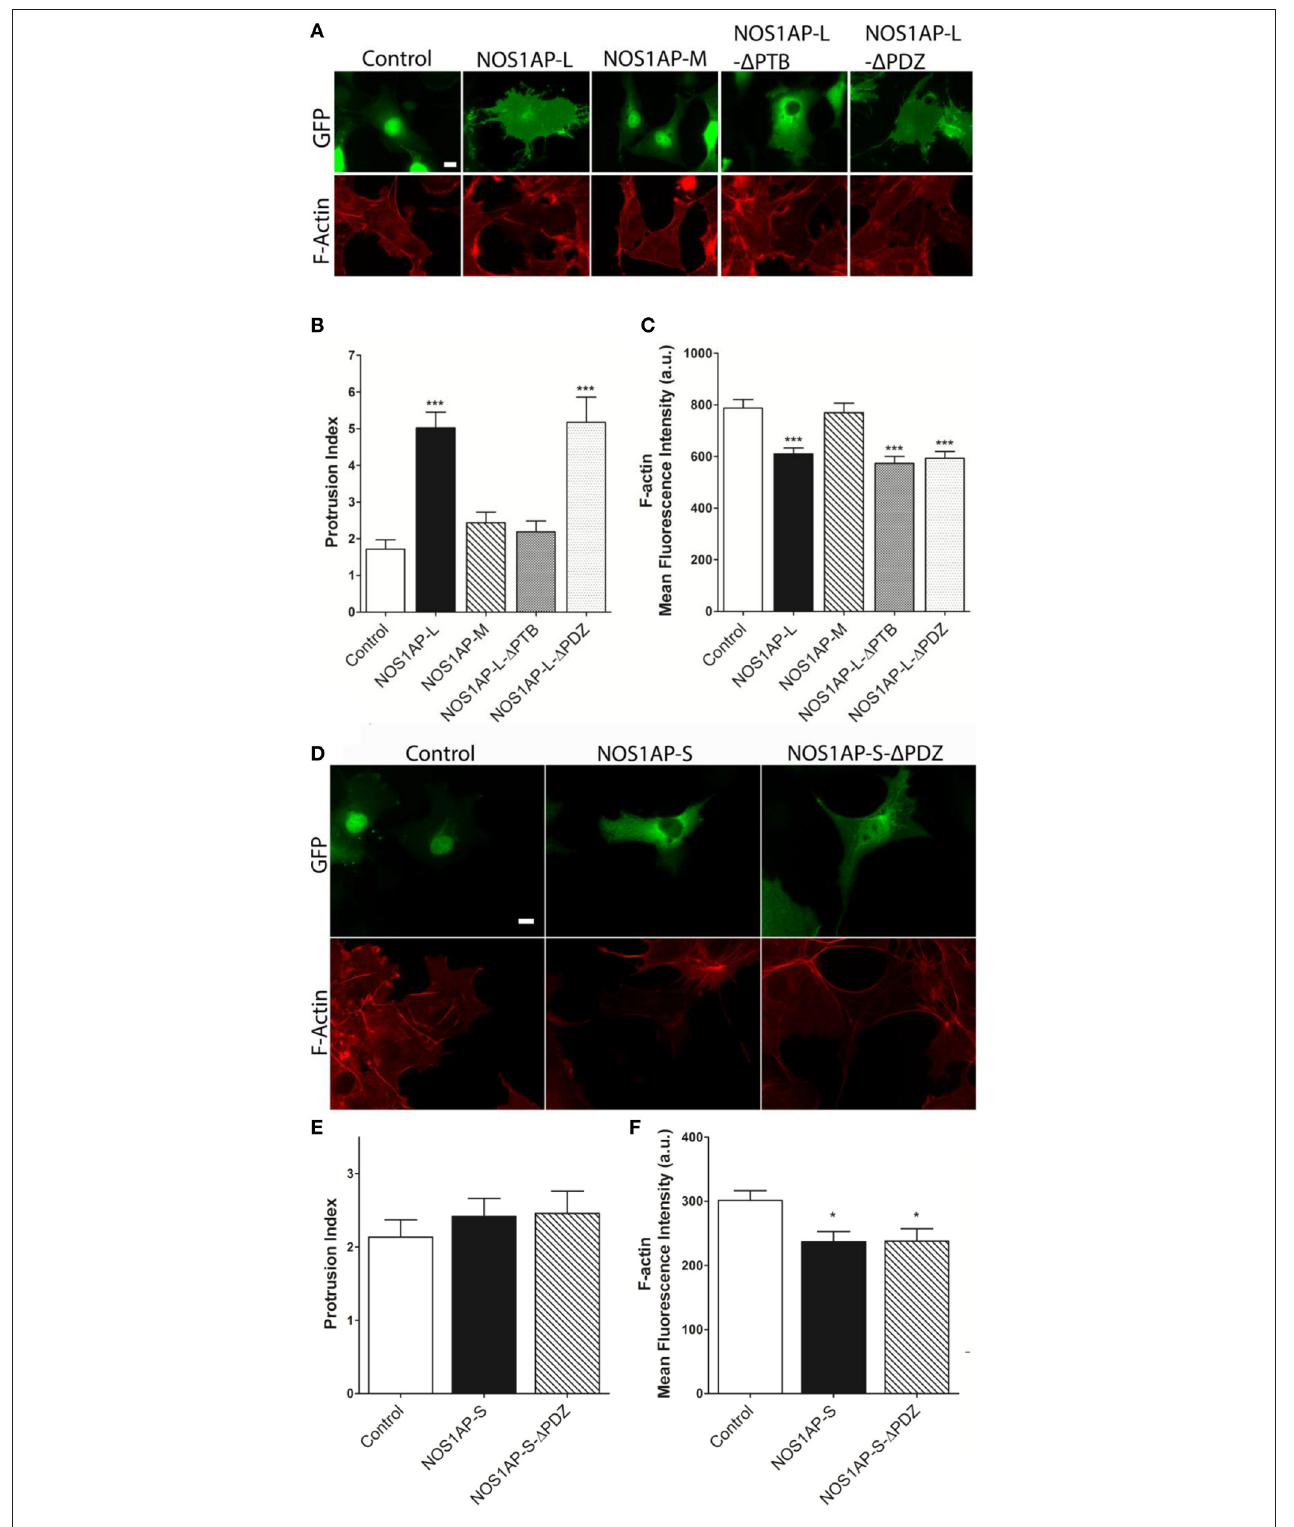
FIGURE 2 | Effects of NOS1AP-L or NOS1AP-S overexpression on protrusion index and F-actin. (A) Representative images of Alexa Fluor ® 647 phalloidin staining of cells expressing GFP (Control), NOS1AP-L, NOS1AP-M, NOS1AP-L- 1 PTB, or NOS1AP- 1 PDZ. (B) Quantitation of protrusion indices from COS-7